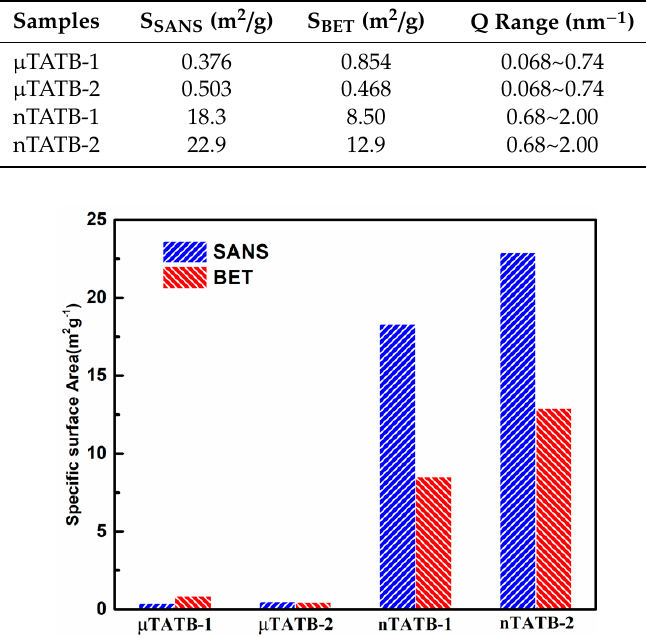
Figure 4. Comparison of specific surface area derived from SANS method and BET for both micro-sized and nano-sized samples (corresponding to the data listed in Table 1).